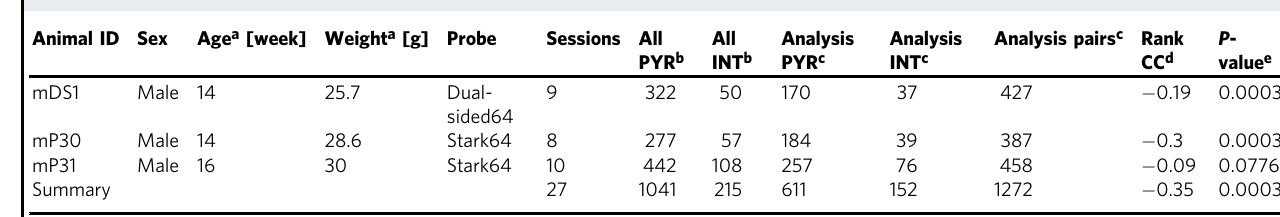
Table 4 List of experimental animals.